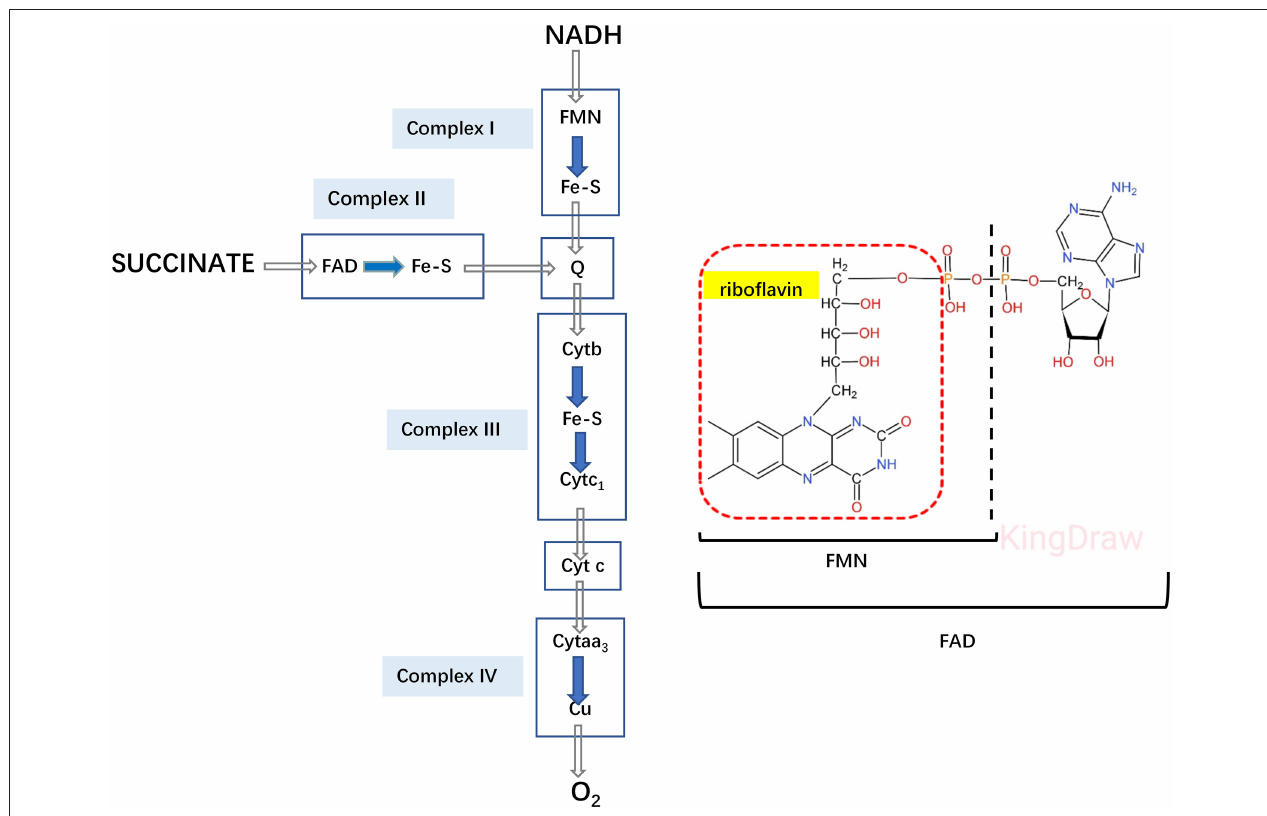
FIGURE 4 | Electron transfer system in the respiratory chain. Riboflavin is converted to FAD, as cofactor for both ETF and ETFDH, also enter as a coenzyme for complex I and II in the respiratory chain.